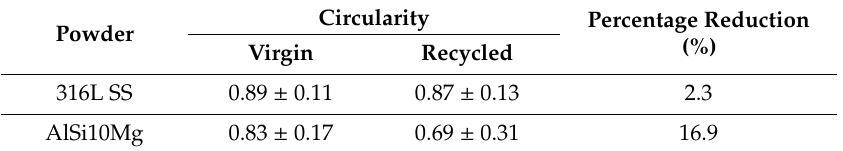
Table 1. Average circularity of virgin and recycled 316L SS and AlSi10Mg powders. Powder